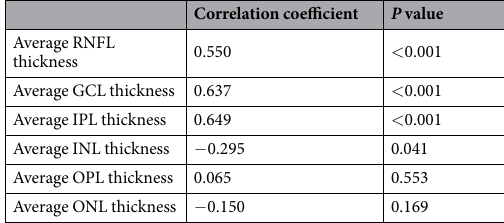
Table 3. Pearson correlation coefficient on segmented retinal layer thicknesses in the macular area and corresponding visual field sensitivities * . * Corresponding mean sensitivity value (dB) was measured by 24-2 SAP. RNFL = retinal nerve fiber layer; GCL = ganglion cell layer; IPL = inner plexiform layer; INL = inner nuclear layer; OPL = outer plexiform layer; ONL = outer nuclear